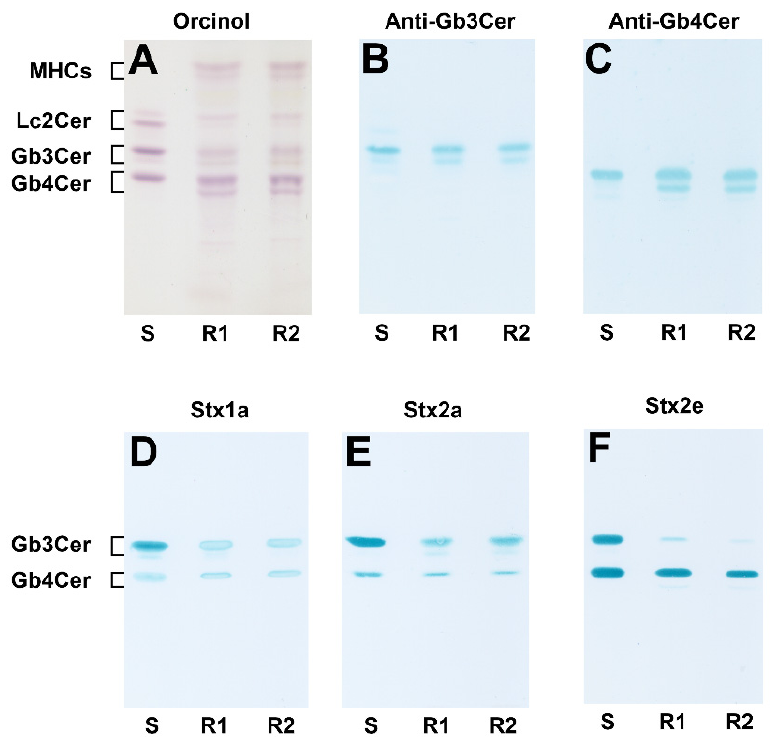
Figure 1. Orcinol stain ( A ) and antibody- ( B , C ) and Stx-mediated TLC overlay detection ( D – F ) of Gb3Cer and Gb4Cer in GSL preparations of serum-free cultivated pHCoEpiCs. The applied GSL quantities correspond to 5 × 10 6 cells for the orcinol stain ( A ), 5 × 10 5 cells for the anti-Gb3Cer ( B ) and anti-Gb4Cer overlay assay ( C ), respectively, and to 1 × 10 6 cells for the Stx overlay assays ( D – F ). Deployed amounts of the standard mixture (S): 6 µ g ( A ), 2.5 µ g and 0.25 µ g ( B and C , respectively), and 2.6 µ g ( D – F ) of a neutral GSL preparation containing equimolar amounts of Gb3Cer and